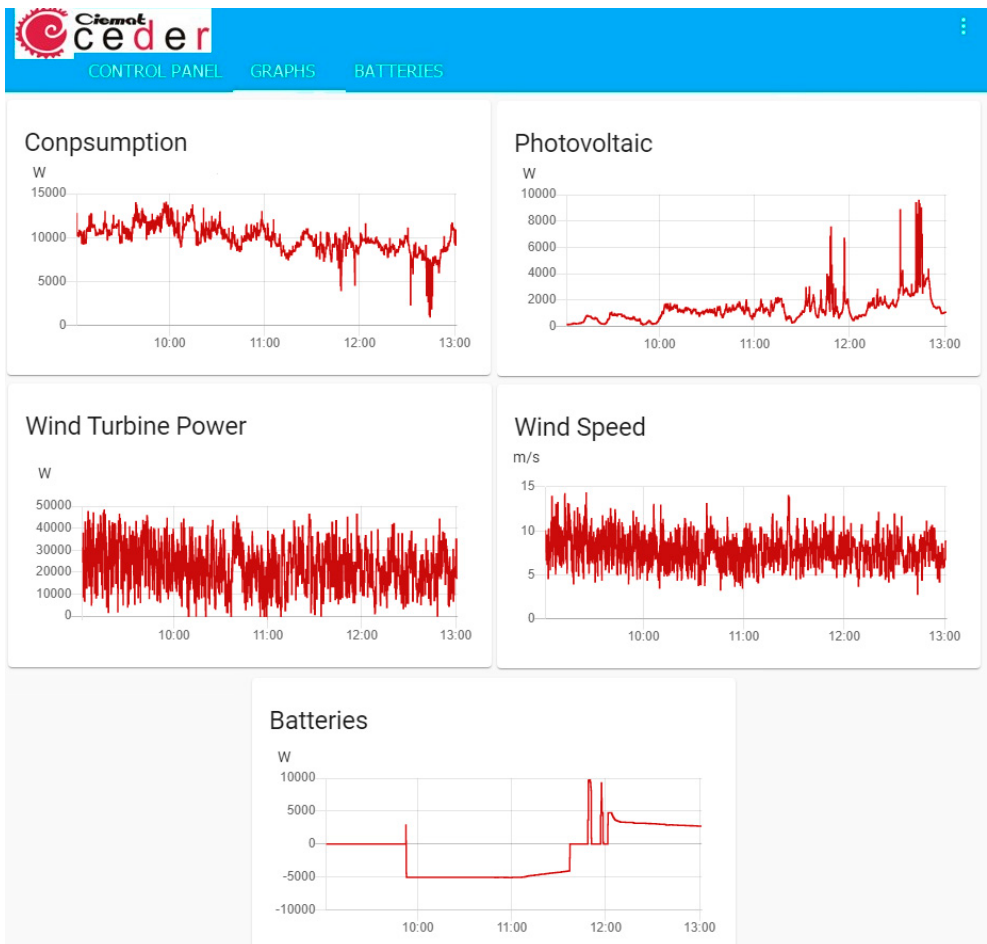
Figure 9. CEDER’s microgrid elements’ instantaneous values graphically represented. Source: